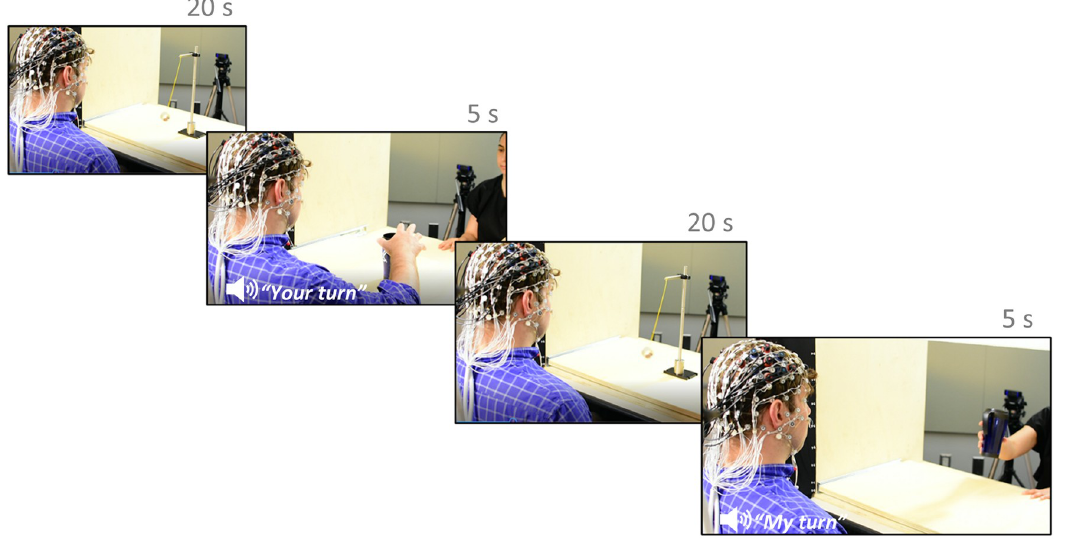
Fig 2. Experimental paradigm. (a and c) Baseline condition (observing a moving pendulum) (b) Action execution (d) Action Observation. The individual in this picture has given written informed consent (as outlined in PLOS consent form) to publish these case